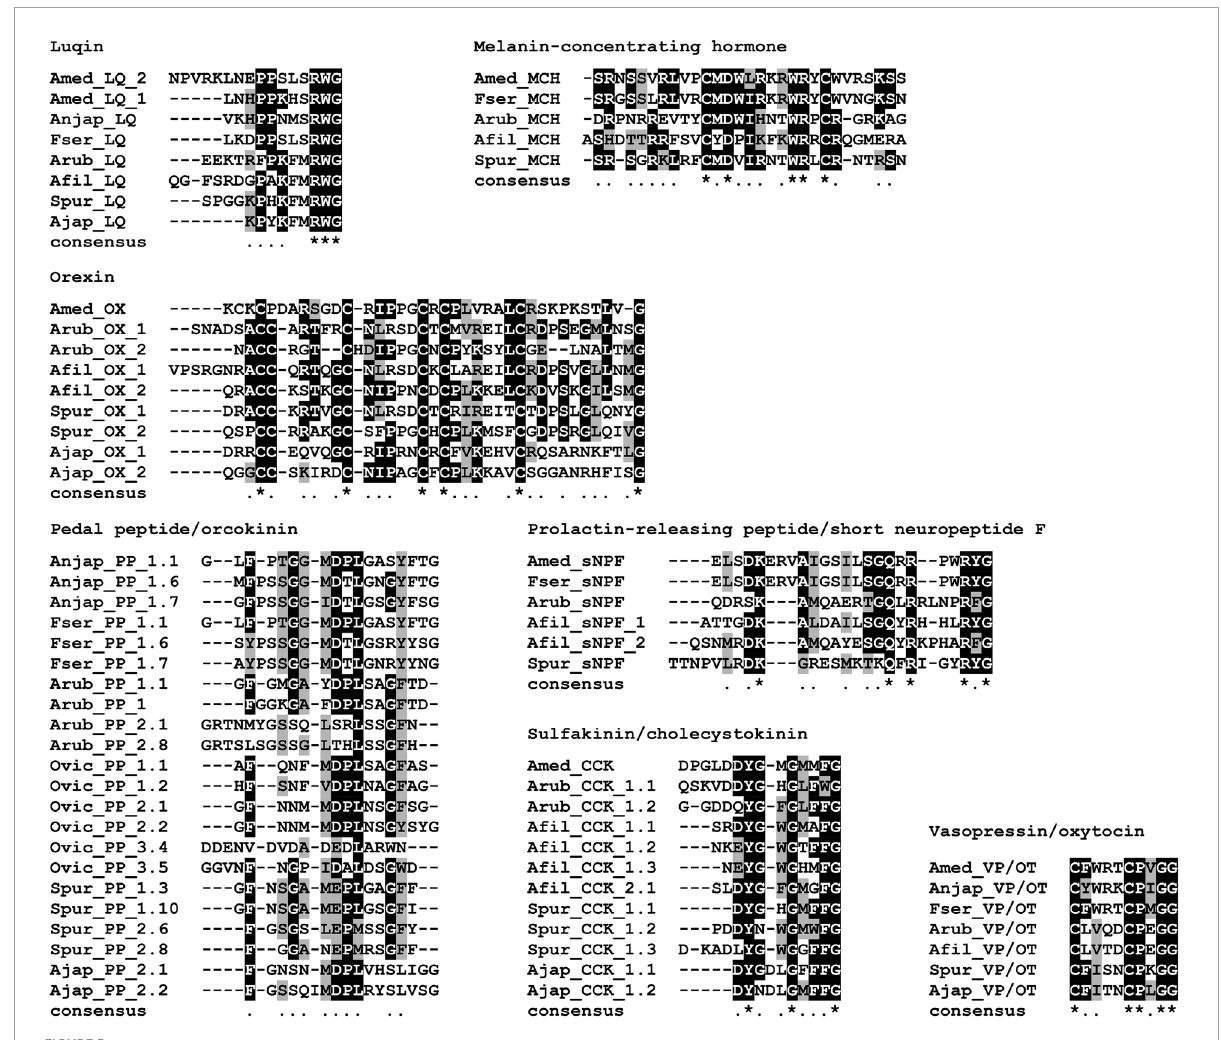
FIGURE5 Alignments of predicted crinoid monomeric neuropeptides with homologous neuropeptides in eleutherozoan echinoderms. Neuropeptide sequences from all three crinoid species are shown, where known, and aligned with the sequences of homologous neuropeptides, where known, from two asterozoan species (starfish and brittle star) and two echinozoan species (sea urchin and sea cucumber). Species name abbreviations: Amed, Antedon mediterranea ; Anjap, Anneissia japonica ; Fser, Florometra serratissima ; Arub, Asterias rubens (starfish); Afil, Amphiura filiformis (brittle star); Spur, Strongylocentrotus purpuratus (sea urchin) and Ajap, Apostichopus japonicus (sea cucumber). Alignments were performed using MAFFT (v7.470) with default parameters and conserved amino acids were highlighted using a threshold fraction of conserved sequences of 0.60 with Boxshade